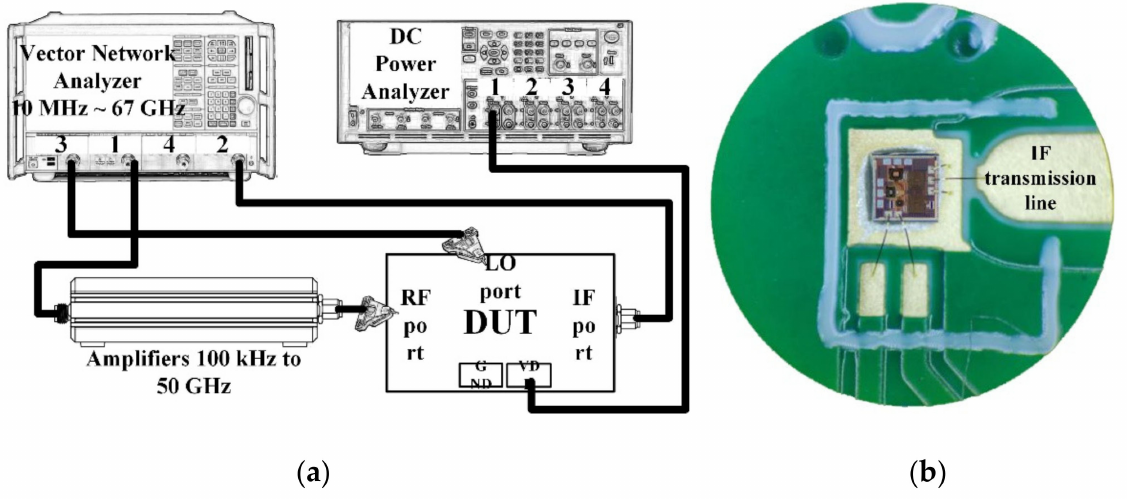
Figure 15. ( a ) Block diagrams of measurement setups, and ( b ) micrograph of the PCB board for